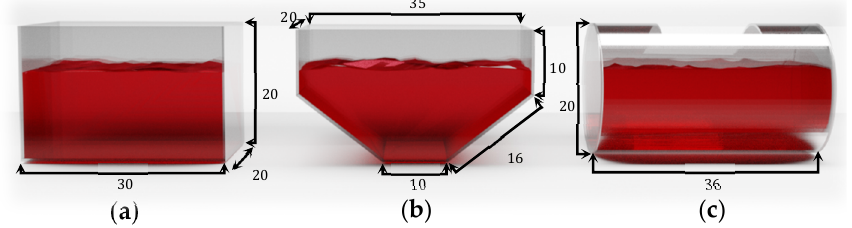
Figure 3. Three basic tanks’ dimensions (cm): ( a ) rectangular, ( b ) flat hexagonal, and ( c ) cylindrical.